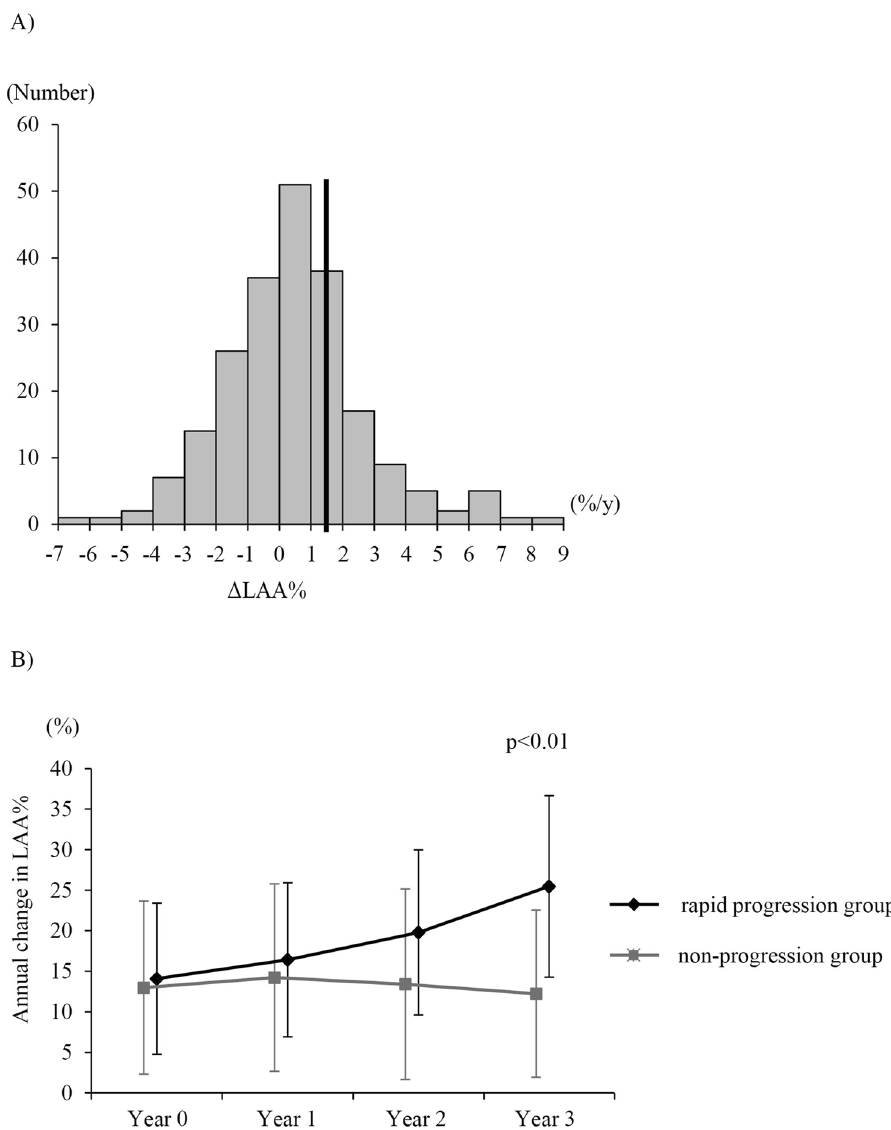
Figure 1. Distribution of annual changes in LAA% and time-dependency over 3 years. ( A ) Distribution of the annual changes in LAA% over the 3-year period. The mean ± SD of ΔLAA%/year was 0.47 ± 2.28. We had arbitrarily defined the cut-off value of ΔLAA%/year, based on the upper quartile value, as 1.48%/year. ( B ) Overall time-dependent LAA% in the rapid progression and non-progression groups. Data are shown as mean ± SD. LAA low attenuation